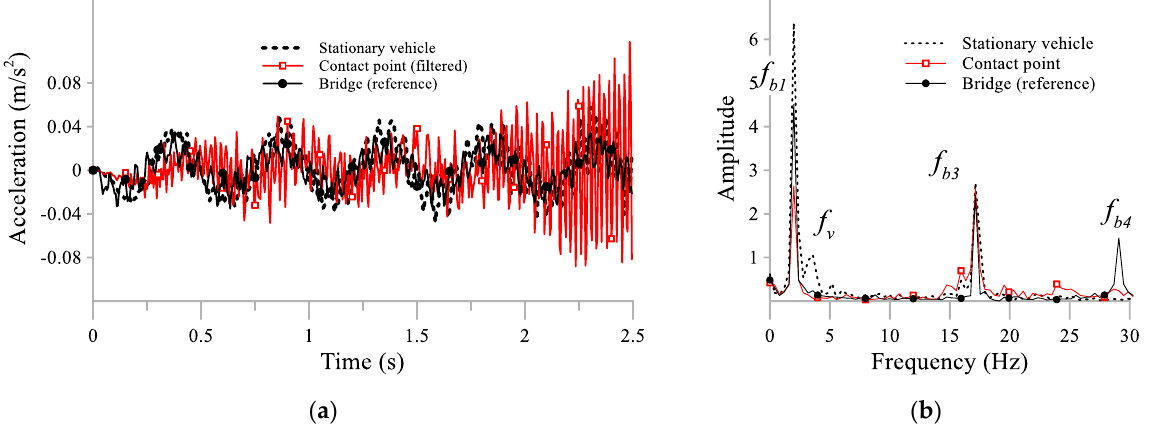
Figure 18. Filtering the contact-point signal of the damped stationary vehicle ( a ) acceleration response and ( b ) the acceleration spectra.